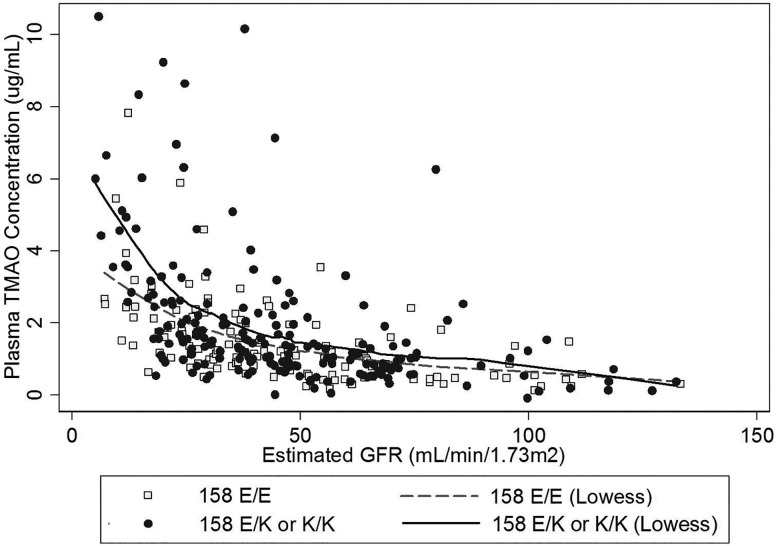
Scatterplot of plasma TMAO concentration versus estimated GFR for subjects with FMO3 E/E (open square) and FMO3 E/K or K/K (closed circle) allelic variants.TMAO concentration increases as eGFR decreases, with greater rate of increase observed with eGFR < 40 mL/min/1.73m2. Dashed line indicates the Lowess curve for reference allele homozygous subjects (158 E/E). Dotted line indicates the Lowess curve for heterozygous or variant homozygous subjects (158 E/K or K/K).